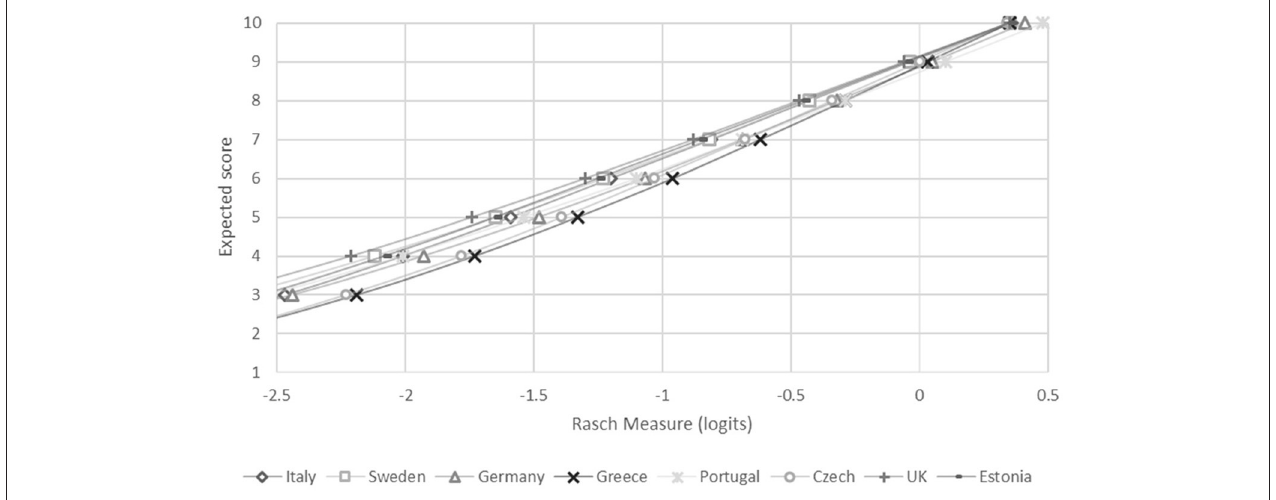
FIGURE 6 | Differential Test Functioning based on the